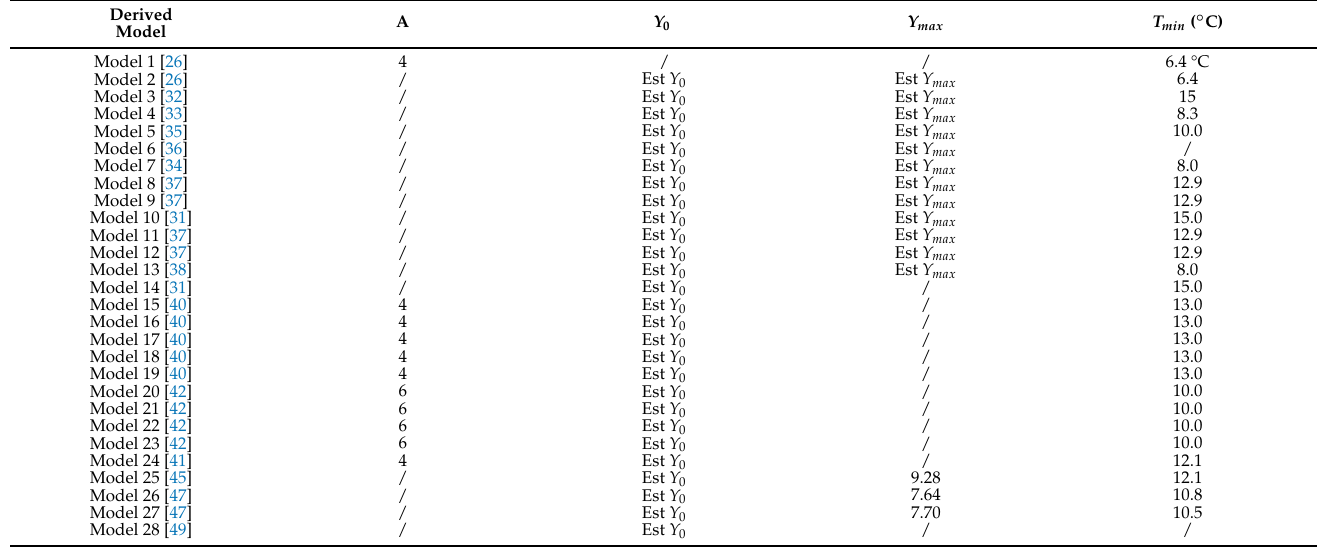
Table A1. List of parameters used in primary model analysis. Parameter A is the maximum increase in microbial cell density, and Y 0 and Y max represent logarithm of initial and maximum bacterial counts, respectively. Parameter T min is the minimum temperature required for growth of the organism. We used the minimum value from dataset divided by 2 (Est Y 0 ) to estimate initial bacterial count whenever it was not provided by the authors. In cases where the maximum bacterial count was not provided, we used the estimate of the maximal bacterial count from each dataset (Est Y max ). Parameters used in secondary models are available in the provided